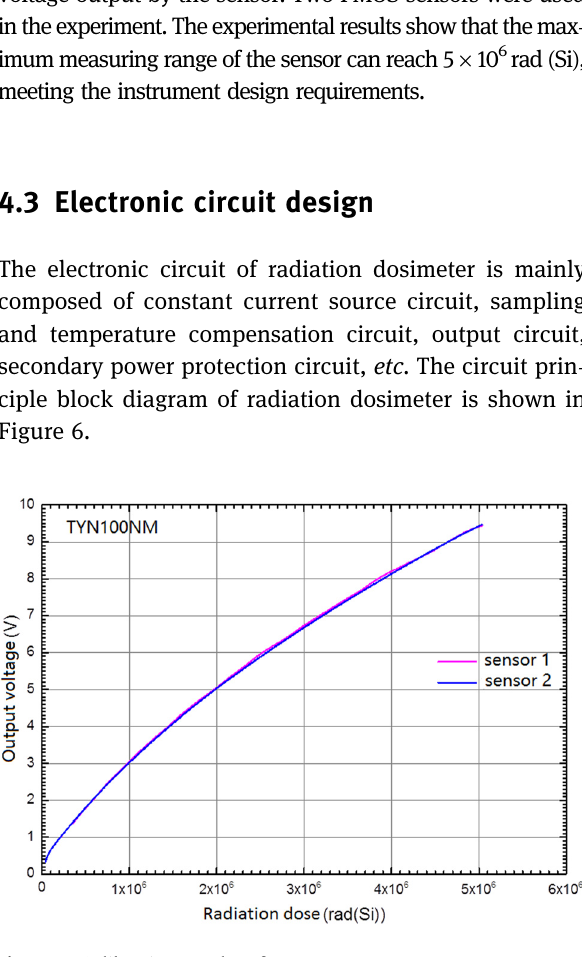
Figure 5: Calibration results of 100 nm RADFET.